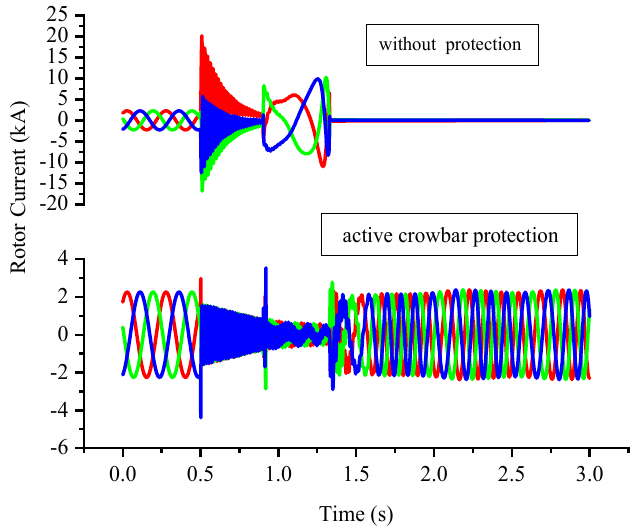
Figure 6. Comparison of the rotor current whether to add active crowbar protection circuit.